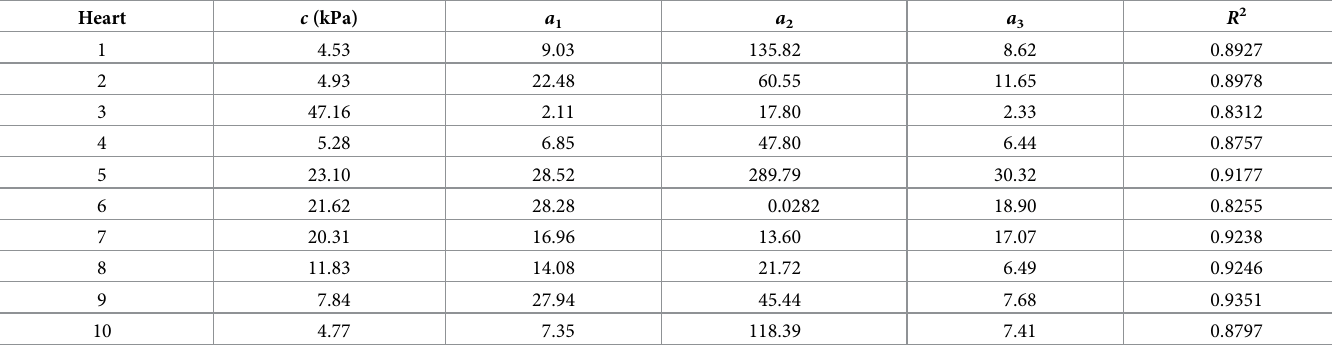
Table 2. Pre-elastase fitting parameters for Fung-type strain energy